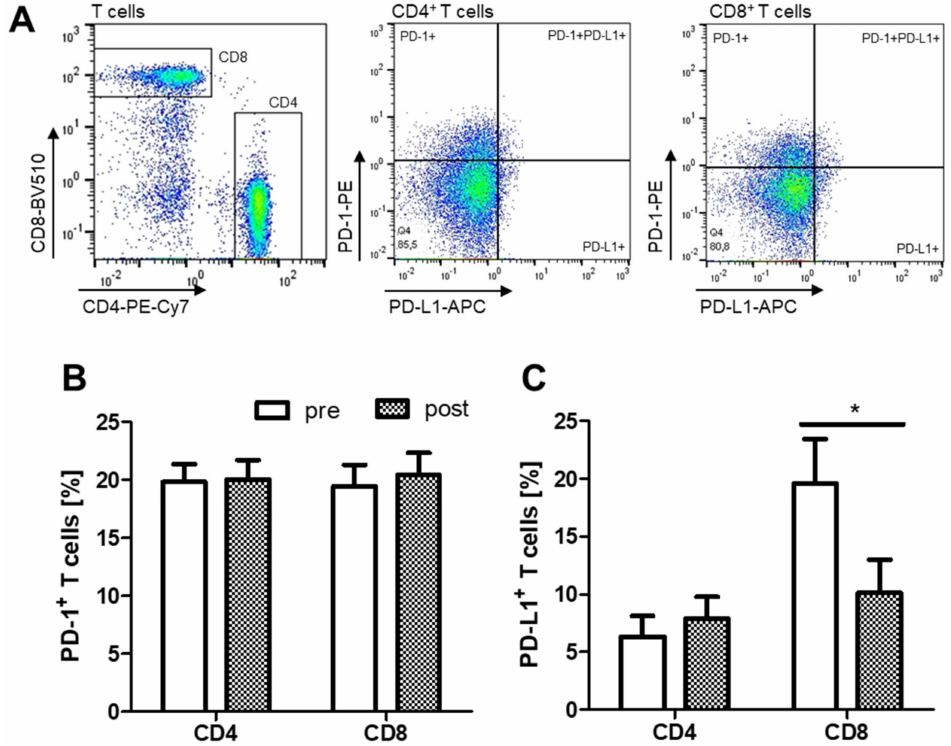
Figure 5. Flow cytometric analysis of CD4 + and CD8 + T cell subsets in PBMC from OSA patients ( n = 22) before and after PAP treatment. ( A ): Gating scheme of PD-1 + and PD-L1 + cells within the CD4 + and CD8 + T cell subset. ( B ): Percentages of PD-1 + cells within the whole CD4 + or CD8 + T cell subset. ( C ): Percentages of PD-L1 + cells within the whole CD4 + or CD8 + T cell subset. *: p < 0.05.